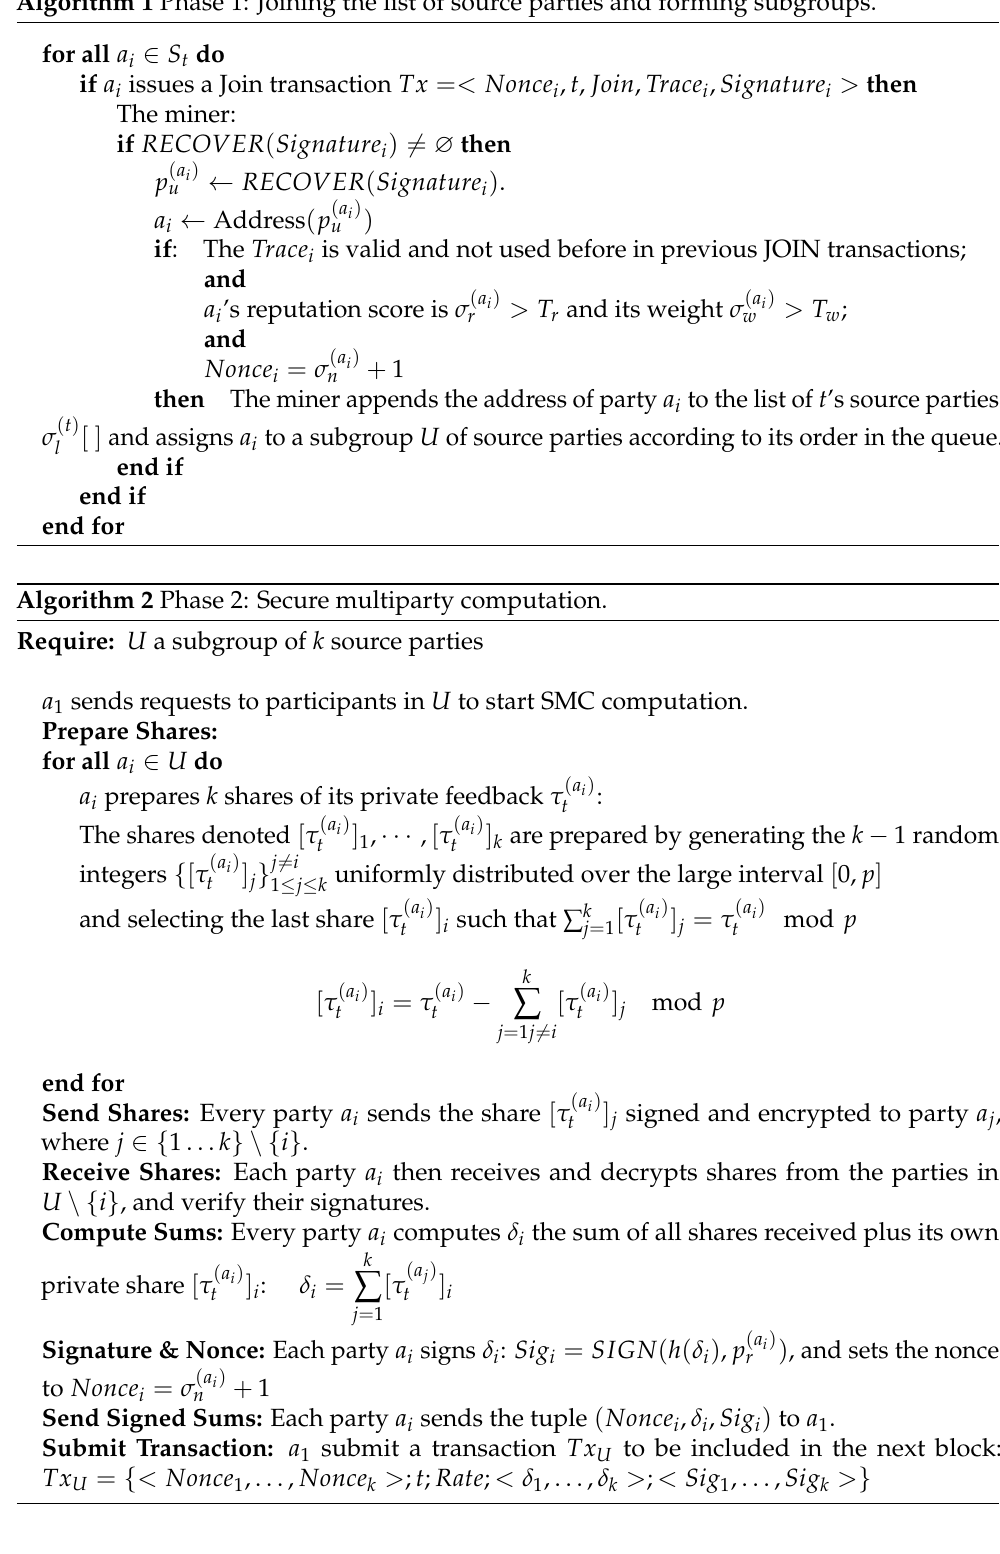
Algorithm 1 Phase 1: Joining the list of source parties and forming subgroups.